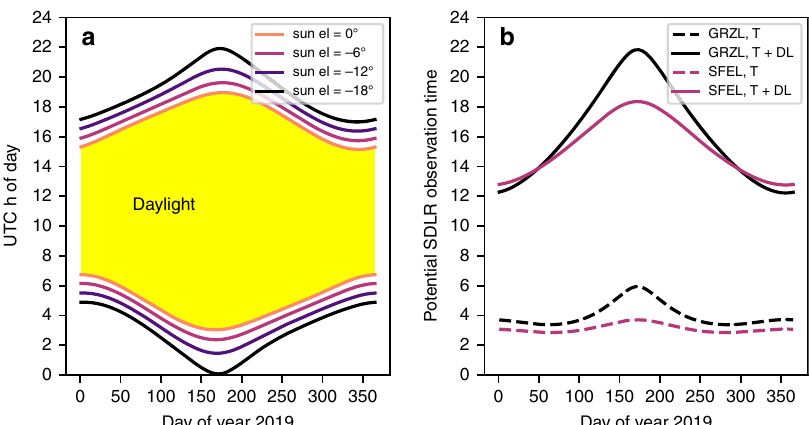
Fig. 2 Twilight phases and potential space debris observation time. a Astronomical, nautical, and civil twilight for Graz during the year 2019. The twilight phases correspond to sun elevations of − 18°, − 12°, − 6°, and 0°. b The total potential time of space debris laser ranging observation time increases in Graz (GRZL, black, latitude 47.1°N) to up to 22 h including the twilight (T) phase and full daylight (DL). At the lower latitude San Fernando laser ranging station (SFEL, red, latitude 36.5°N) potential observation times increase to approximately 18 h.